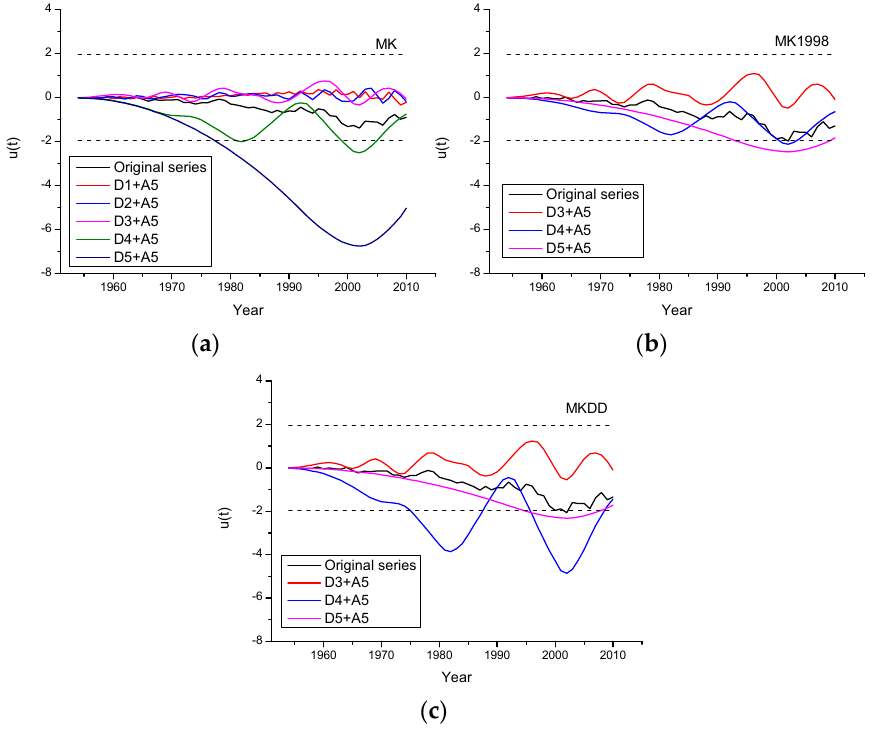
Figure 17. Three sequential Mann-Kendall graphs of annual total precipitation series exhibiting the progressive trend lines of each detail component (with the addition of the approximation) with respect to the original series. The upper and lower dashed lines represent the confidence limits ( α = 5%). ( a ) MK; ( b ) MK1998; ( c ) MKDD.